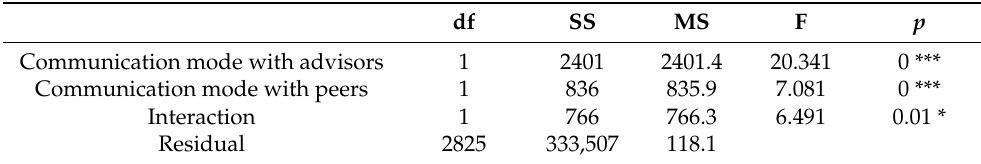
Table 5. Two-way ANOVA results for anxiety. df SS MS F p Communication mode with advisors 1 1924 1923.7 20.70 0 *** Communication mode with peers 1 758 757.5 8.152 0 *** Interaction 1 674 673.7 7.25 0 *** Residual 2825 262,494 92.9